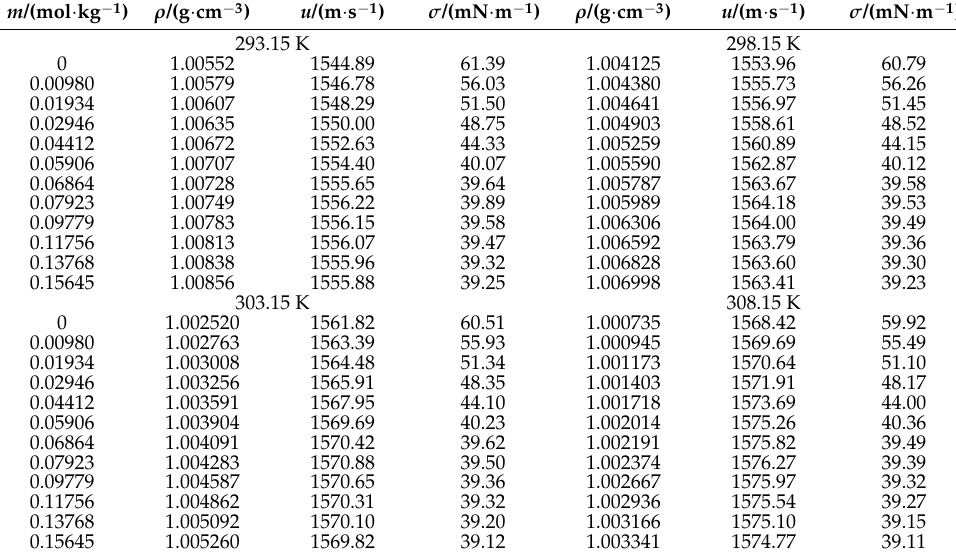
Table 2. Density, sound velocity, and surface tension for decyltrimethylammonium bromide (C 10 TAB) in aqueous solutions of 1,2-propanediol X OH = 0.02481 at temperatures between T = 293.15 K and 308.15 K at 75 kPa.